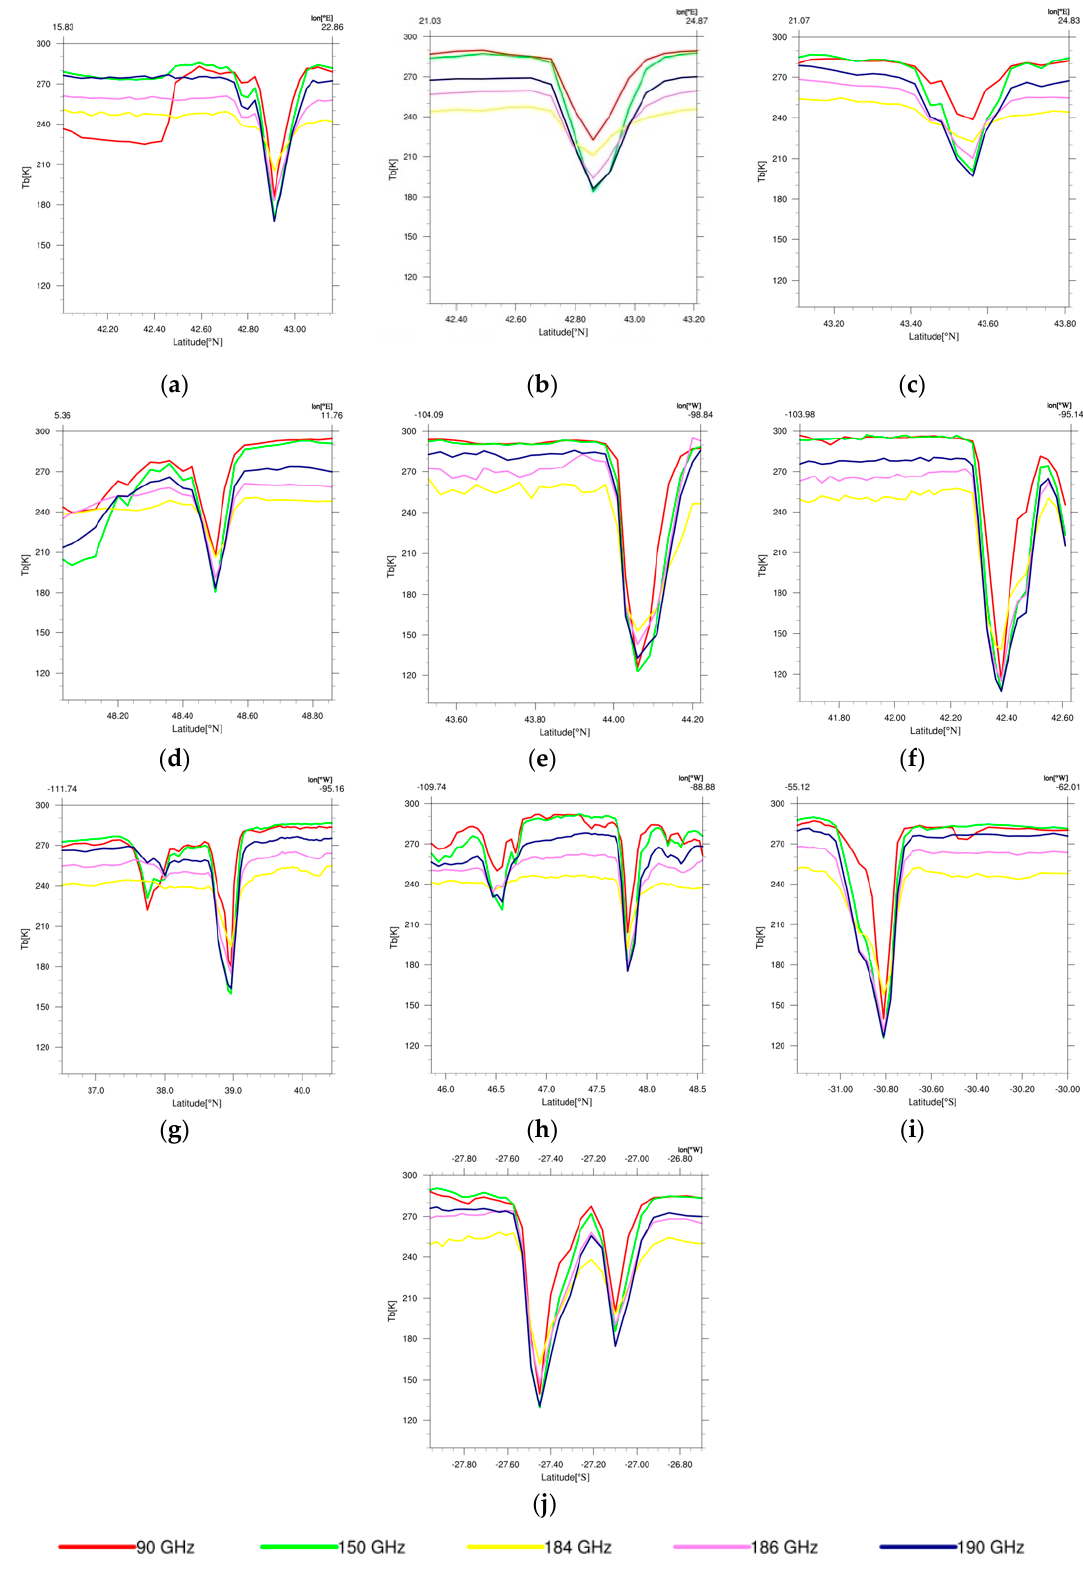
Figure 1. Brightness temperature distribution along transects crossing the main core of the storm for the analyzed case studies: ( a ) Bosnia-Herzegovina (2018 UTC); ( b ) Bulgaria-Sofia (1337 UTC); ( c ) Bulgaria-Montana (1928 UTC); ( d ) Germany (1427 UTC); ( e ) S. Dakota-Vivian (2254 UTC); ( f ) S. Dakota-Charles (2341 UTC); ( g ) Colorado-N. Mexico (0337 UTC); ( h ) Minnesota-N. Dakota (0110 UTC); ( i ) Argentina-Viale (1239 UTC); ( j ) Argentina-Liebig (2136 UTC).